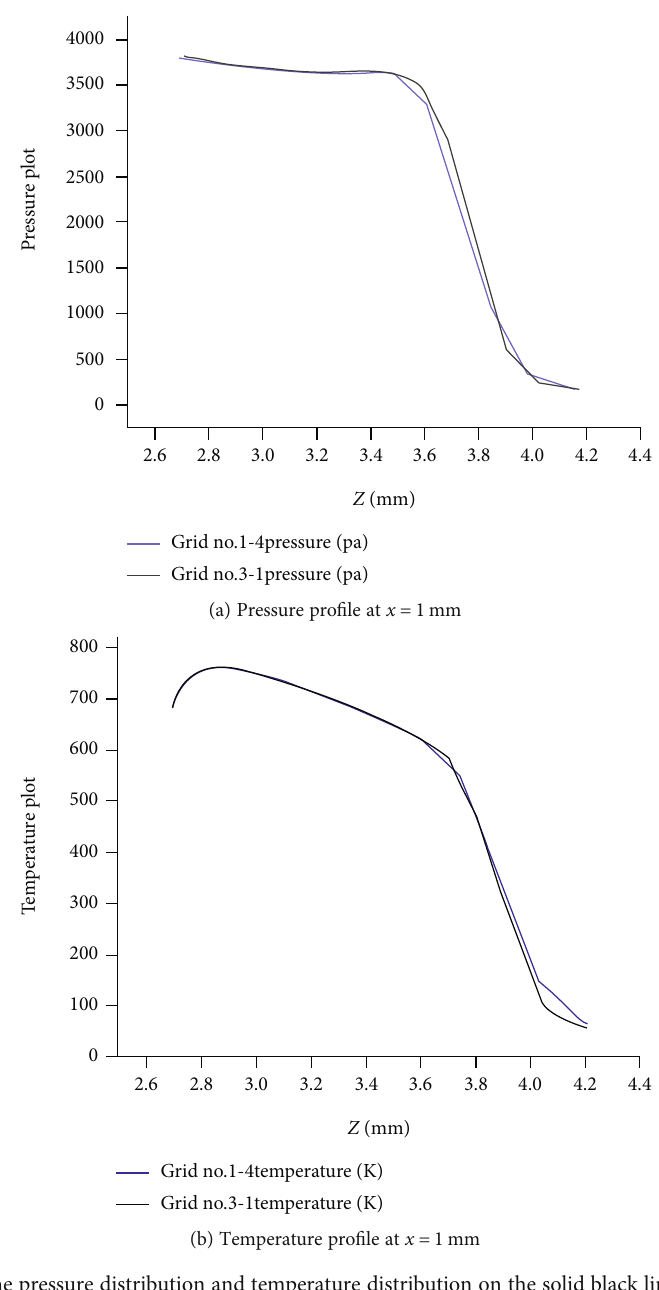
Figure 5: The pressure distribution and temperature distribution on the solid black line in Figure